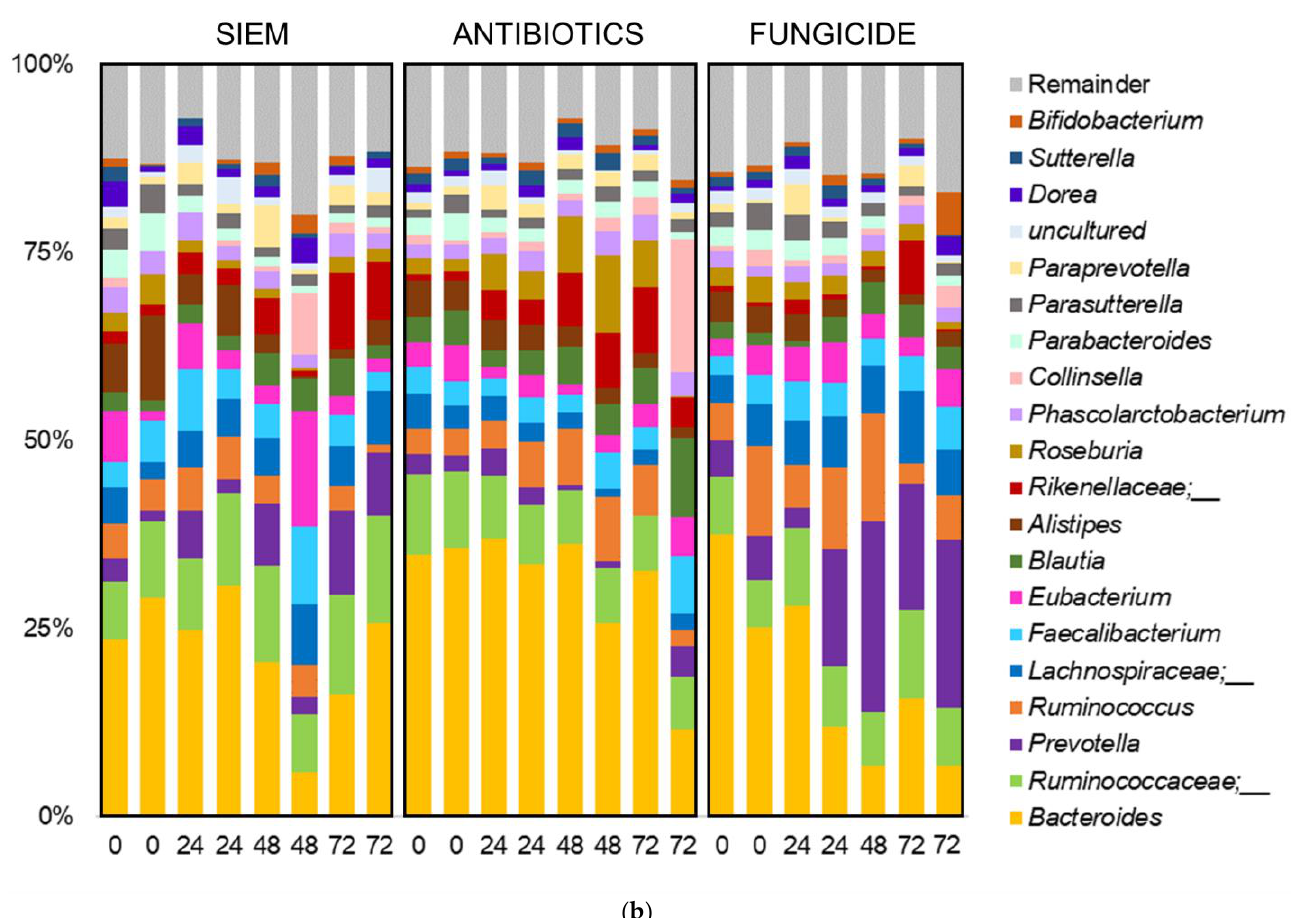
Figure 5. Taxonomic classification of bacteria at ( a ) phylum and ( b ) genus level.